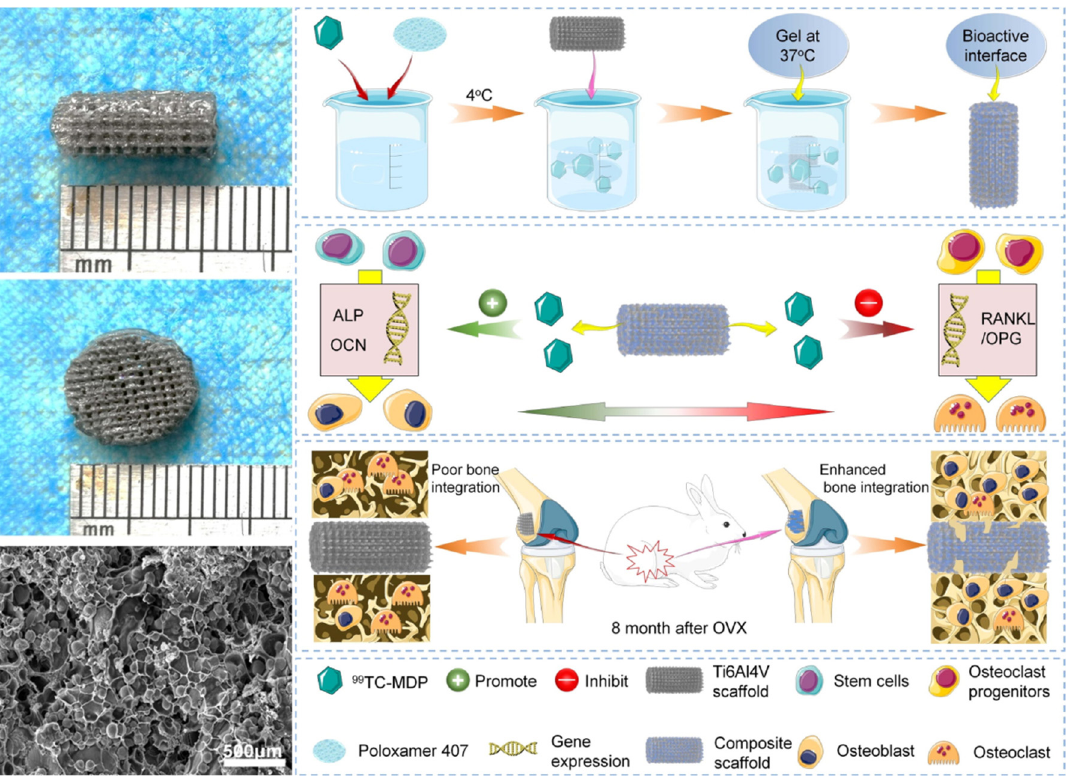
Figure 5. External appearance and representative SEM image of the coated Ti implant, and fabrication of the 99Tc ‐ MDP ‐ loaded hydrogel incorporated bioactive interface (TH/PTI) and its effects of promoting osteogenic differentiation and inhibiting osteoclastogenesis, which results in enhanced os- teoporotic bone integration. Reproduce and adapted from [88] under Creative Commons Attribution 4.0 International License (CC BY